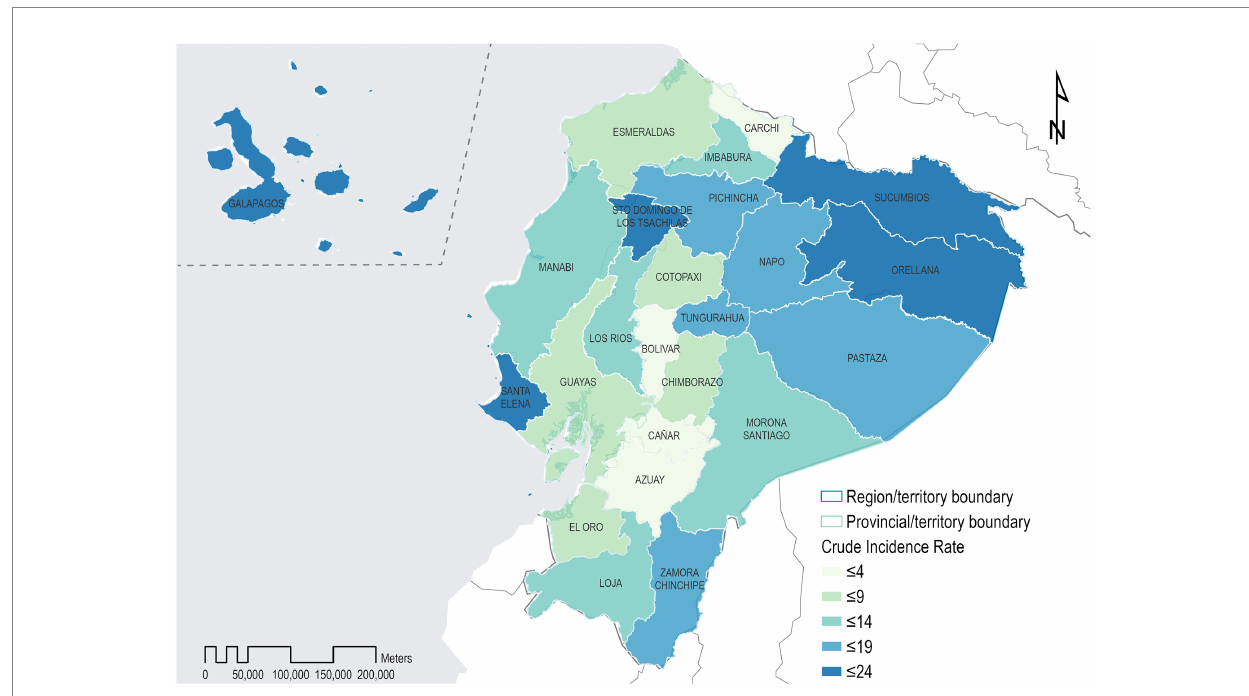
FIGURE 1 Geographical distribution of incidence rates of hospitalization cases for Chagas disease in the provinces of Ecuador, from 2011 to 2021.